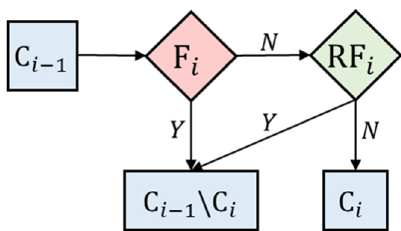
Figure 4. Proposed binary-tree classification model.